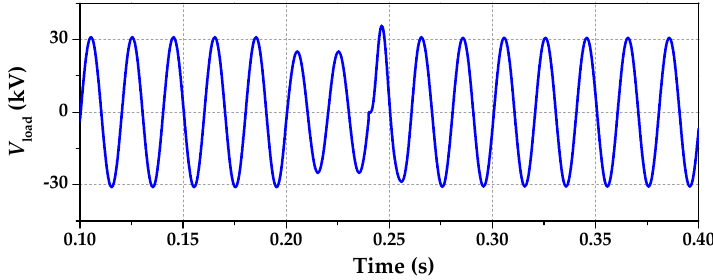
Figure 9. Load voltage as a function of time during a voltage drop and the application of the proposed method with the control system.